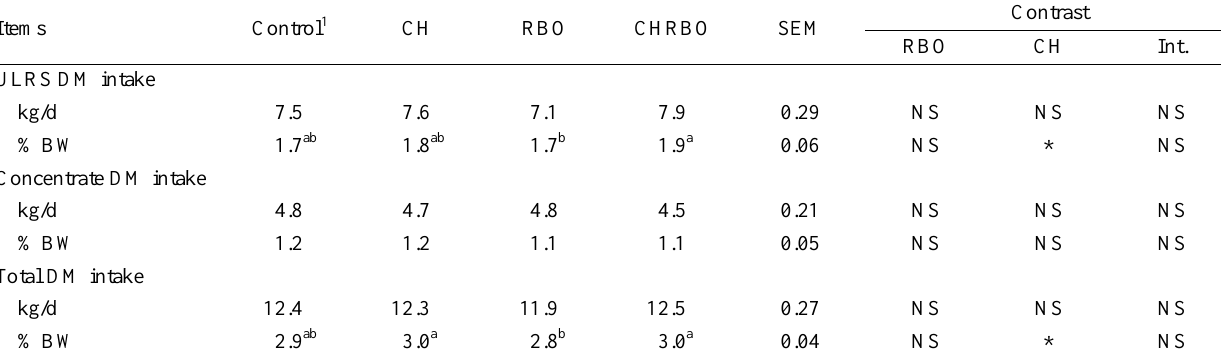
Table 2. Effect of cassava hay and rice bran oil on feed intake in lactating dairy cows